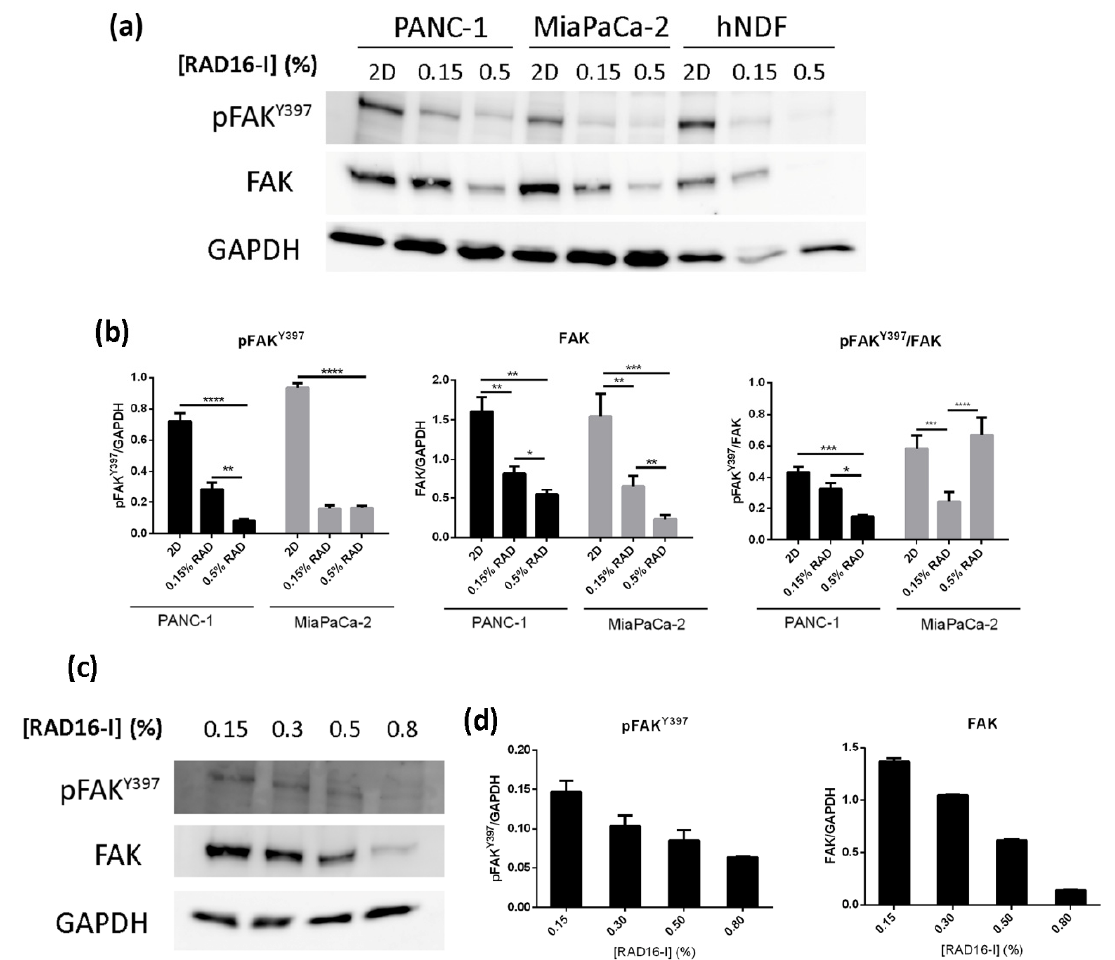
Figure 4. pFAK Y397 and FAK expression in cancer cell lines and normal fibroblasts cultured in RAD16-I hydrogels. ( a ) Western blot bands of pFAK Y397 and total FAK in PANC-1, MiaPaCa-2 and hNDF cells cultured in 2D and 0.15% (soft) and 0.5% (stiff) RAD16-I gels; ( b ) densitometry of bands shown in ( a ); ( c ) Western blot bands of pFAK Y397 and total FAK in PANC-1 cells cultured in 3D RAD16-I hydrogels of increased stiffness (from 0.15% to 0.8% RAD16-I, representing a stiffness range of 100–8500 Pa); ( d ) densitometry of bands shown in ( c ). GAPDH was used as loading control. Statistical differences are indicated as * for p value < 0.05, ** for p value < 0.01, *** for p value < 0.001 and **** for p value < 0.0001.